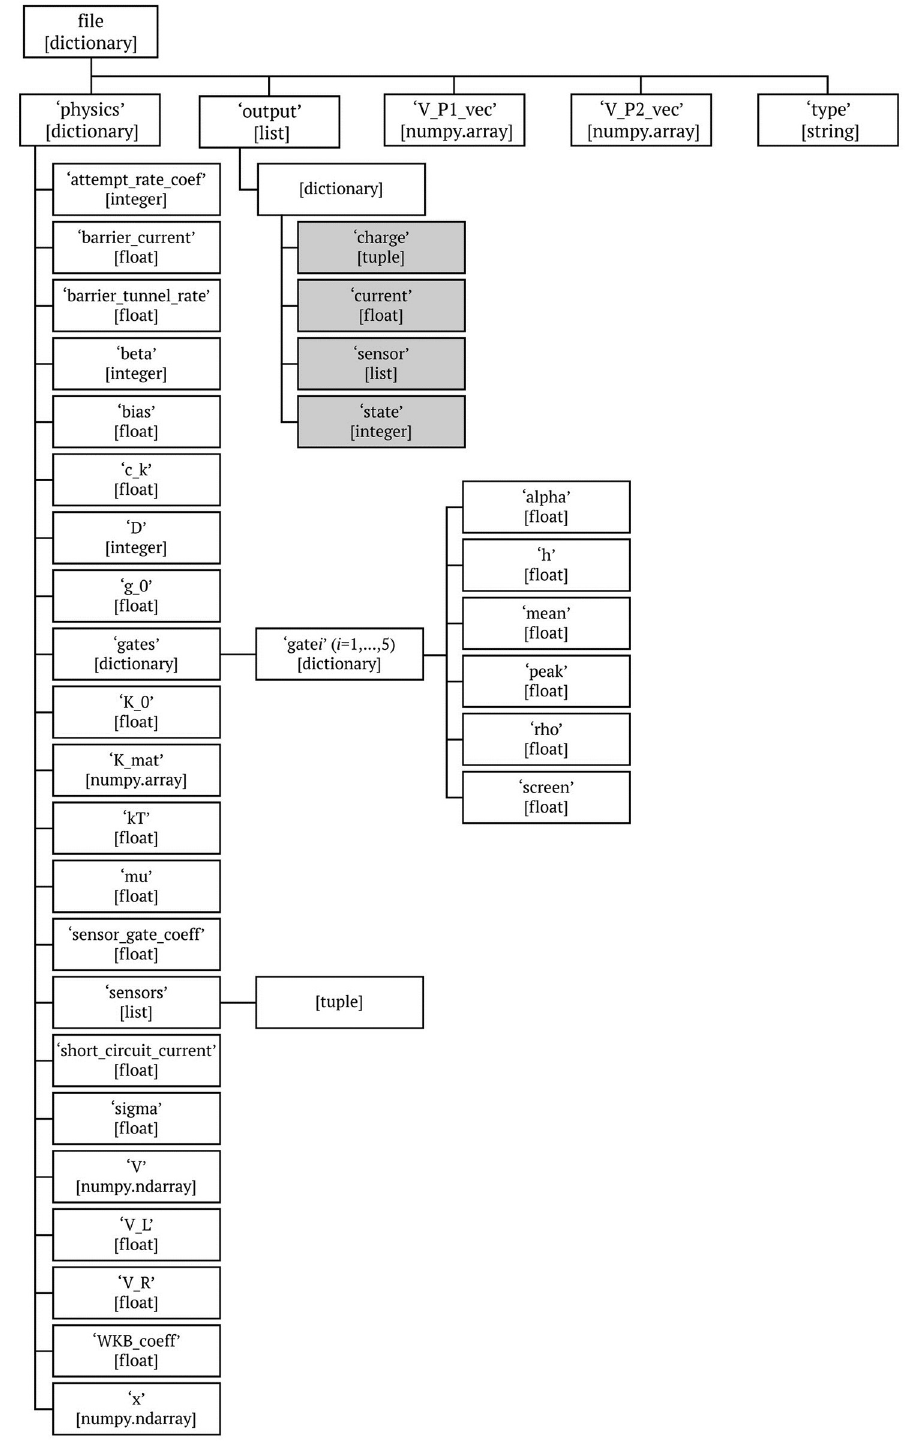
Fig 3. Data structure. The generic data structure tree for the data files. The data type is given in square brackets. The simulation output is highlighted in gray. See Tables 2 and 3 for a reference list.